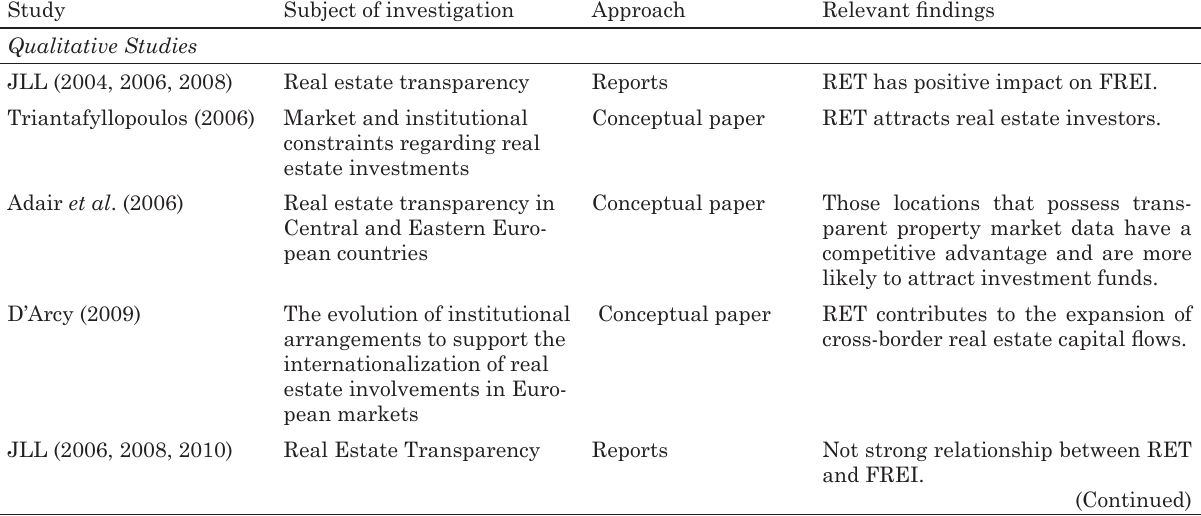
Table 1. Review of the literature on real estate transparency and foreign investments